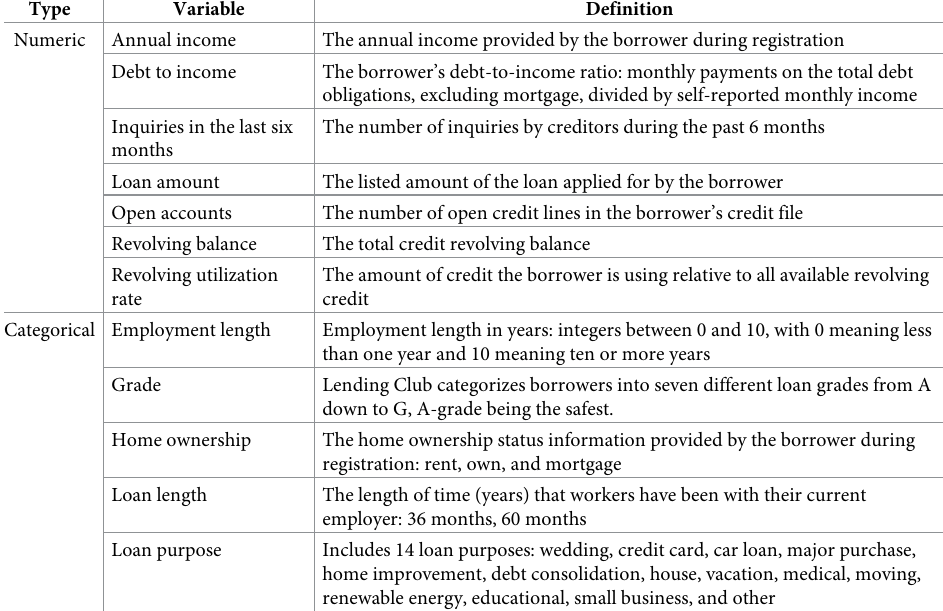
Table 1. Description of attributes used in this